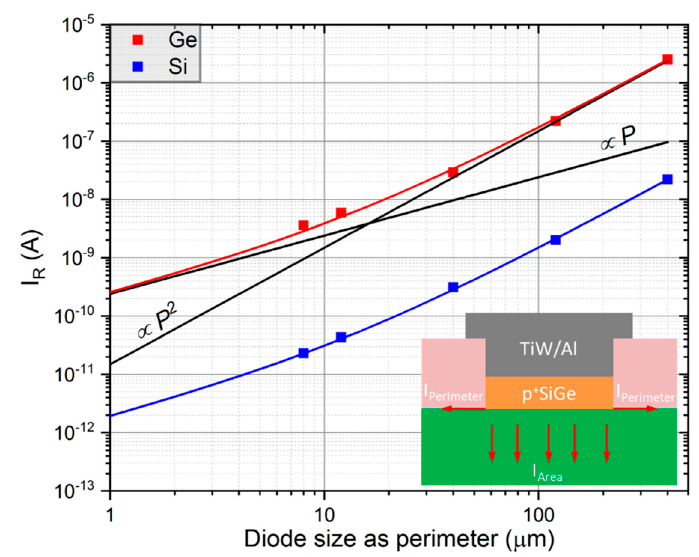
Figure 6. Area and perimeter dependent diode leakage current for Ge and Si substrates. In the insert the two main leakage mechanisms are graphically depicted. The black lines show the reverse current as a function of only area ( P 2 ) or perimeter ( P ). Red and blue lines depict I R for Ge and Si using Equation (1) and fitting parameters I A and I P .